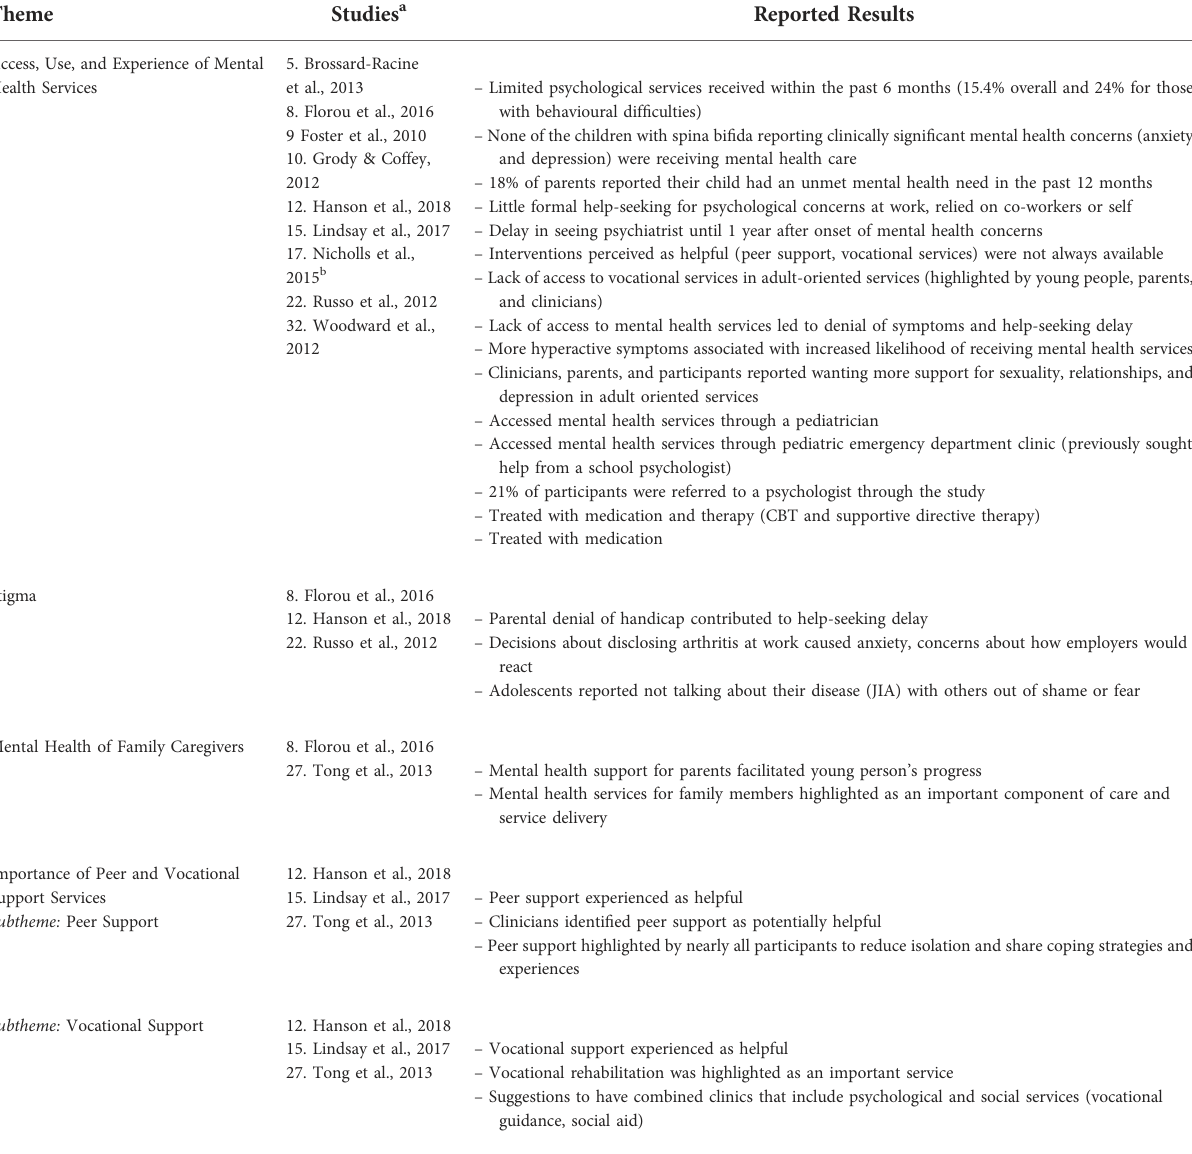
TABLE 5 Experience of mental health problems and mental health services for young people with childhood-onset physical